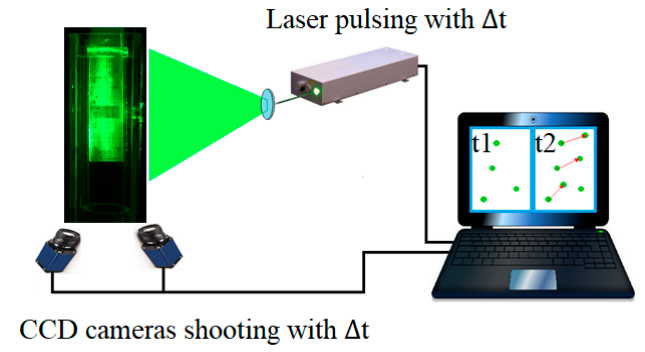
Figure 3. Schematic representation of stereoscopic PIV set-up.